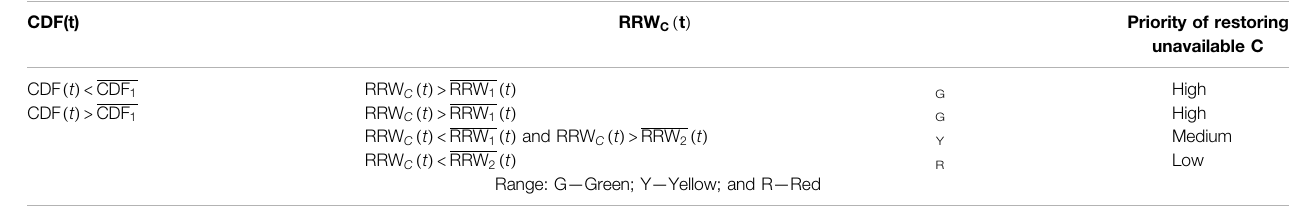
TABLE 4B | Implications and actions of time-dependent criteria of RRW C ( t ) CDF(t)